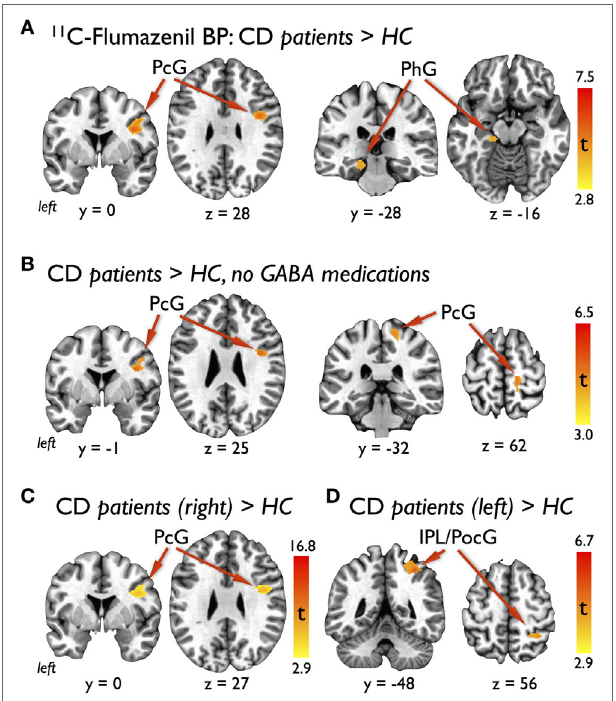
FigUre 1 | Results of voxel-based analyses showing (a) significant clusters in the right lateral precentral gyrus (PcG) and left parahippocampal gyrus (PhG) with increased 11 C-flumazenil binding potential (BP) in cervical dystonia (CD) patients compared with healthy controls (HCs), (B) significant clusters in the right lateral and medial PcG with increased BP in the subgroup of CD patients not taking GABAergic medications compared with HC, (c) significant cluster in the right lateral PcG with increased BP in the subgroup of CD patients with right torticollis compared with HC, and (D) significant cluster in the right inferior parietal lobe (IPL) and postcentral gyrus (PocG) with increased BP in the subgroup of CD patients with left torticollis compared with HC. Voxel-based findings for the primary outcome (a) were FWE corrected for multiple corrections at an individual voxel statistical threshold of p < 0.001 with a cluster threshold of at least 102 contiguous voxels for overall α < 0.05. Significance for the subgroup analyses (B–D) were defined as an individual voxel statistical threshold of p < 0.005 with a cluster threshold of 100 contiguous